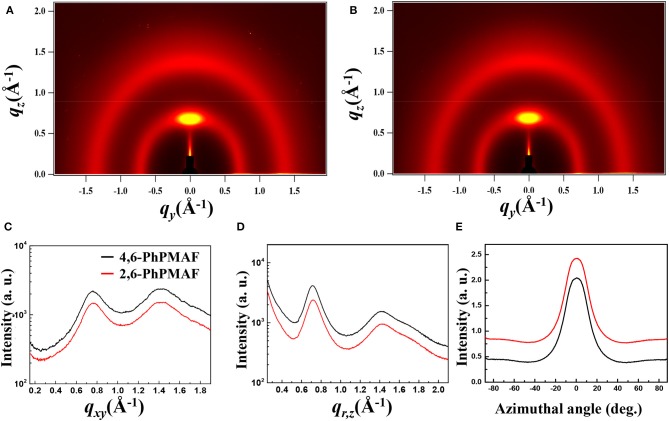
Two-dimensional grazing-incident wide-angle X-ray diffraction (2D GI-WAXD) images of scattered X-ray intensity from surface to full depth for films of (A) DPEPO:4,6-PhPMAF and (B) DPEPO:2,6-PhPMAF on SiO2/Si substrates, y axis: in-plane scattering; x axis: out-of-plane scattering. (C) In-plane scattering spectra; (D) out-of-plane scattering spectra. (E) Azimuthal intensity plots of orientation distributions of sets of crystallographic reciprocal lattice planes of the films.